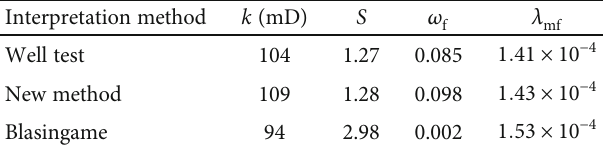
Table 3: Main interpreted parameters for validation case 1.